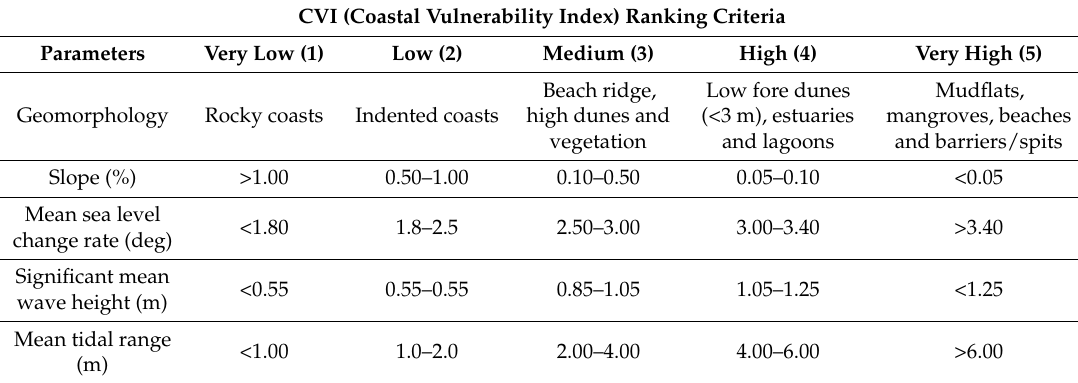
Table 3. Coastal Vulnerability Index ranges with their risk values considered for CAP. Source: